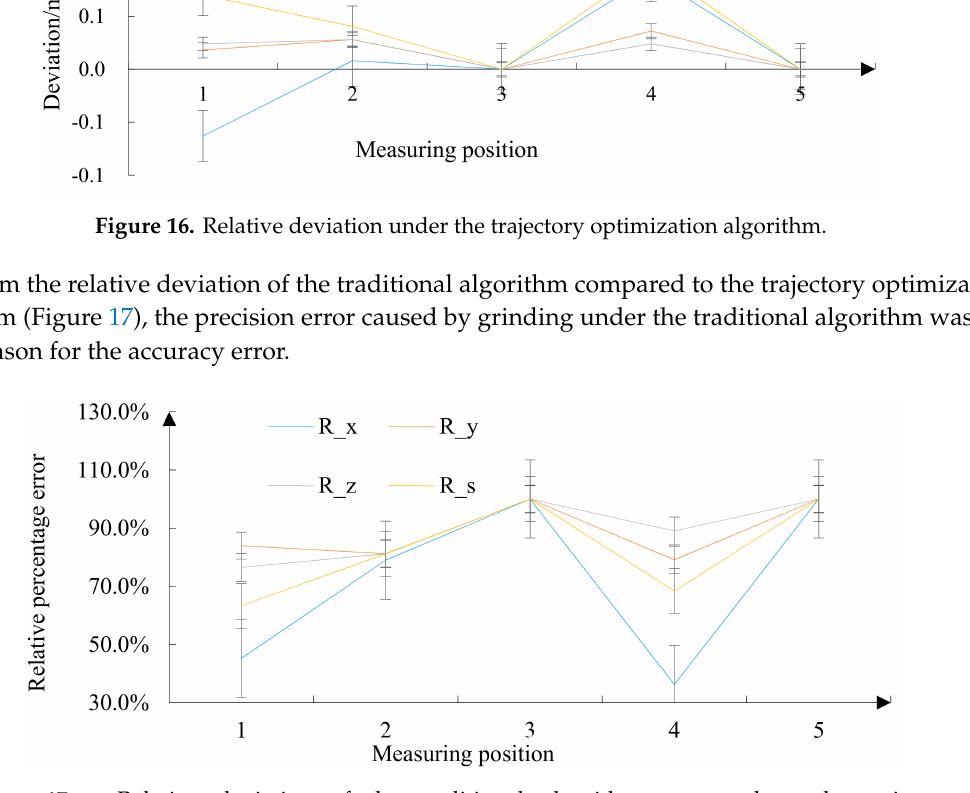
Figure 17. Relative deviation of the traditional algorithm compared to the trajectory optimization